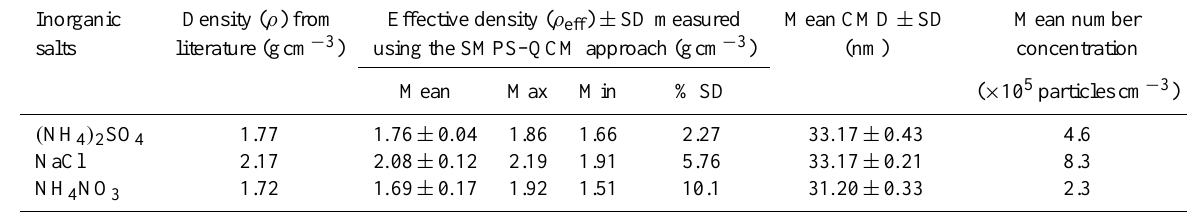
Table 2. Measured effective density of laboratory-generated inorganic salt particles. Inorganic